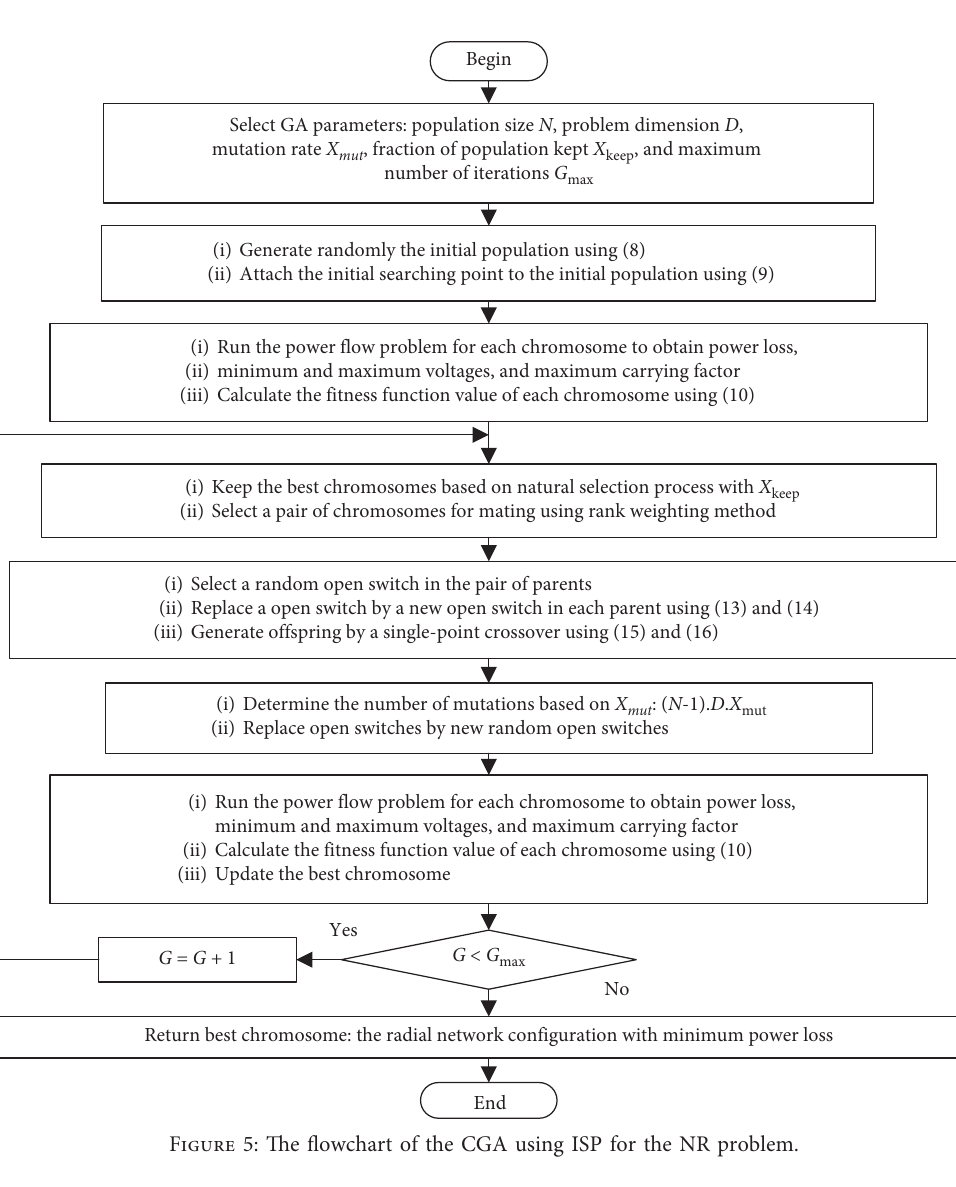
Figure 5: The flowchart of the CGA using ISP for the NR